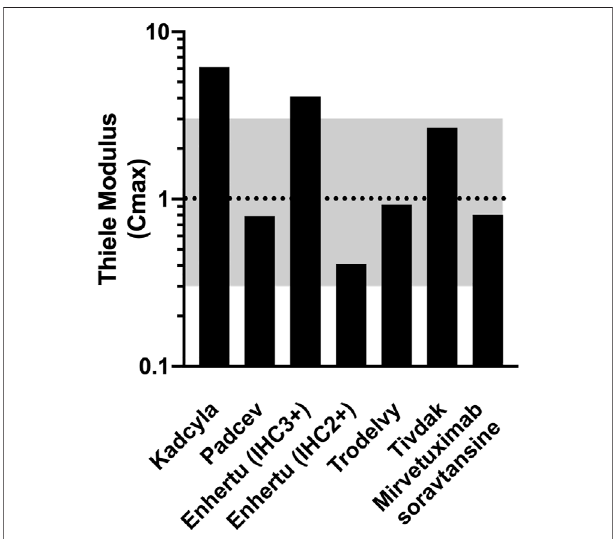
FIGURE 2 | Thiele Modulus of Approved Solid Tumor ADCs and Mirvetuximab soravtansine. Values for most recent agents are close to one indicating a balance between tumor uptake and local